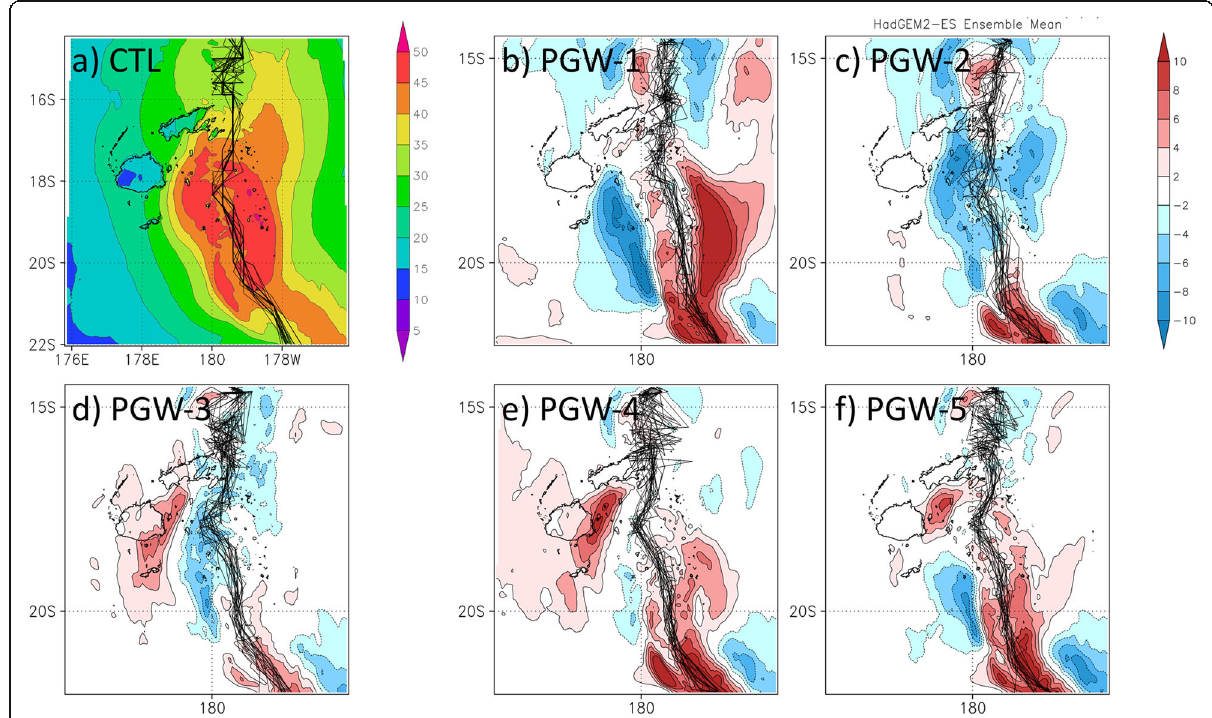
Fig. 11 Spatial distribution of the ensemble mean maximum wind speed. a CTL results (same as Fig. 4). b – f Difference in the ensemble mean maximum wind speed between the CTL and each PGW ensemble simulation. The unit of color bar is